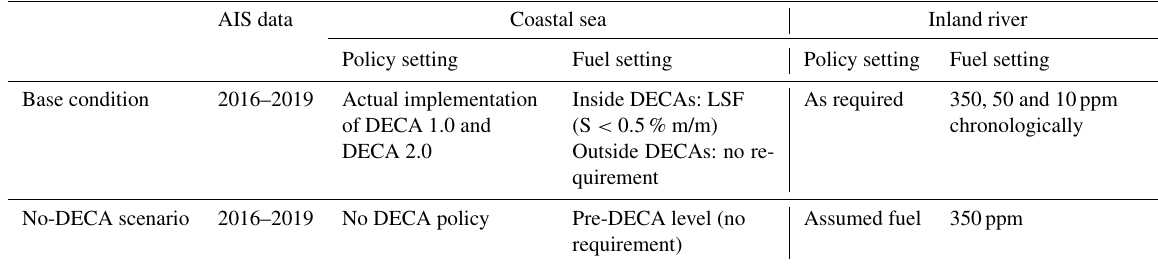
Table 2. Simulation scenario setting in this